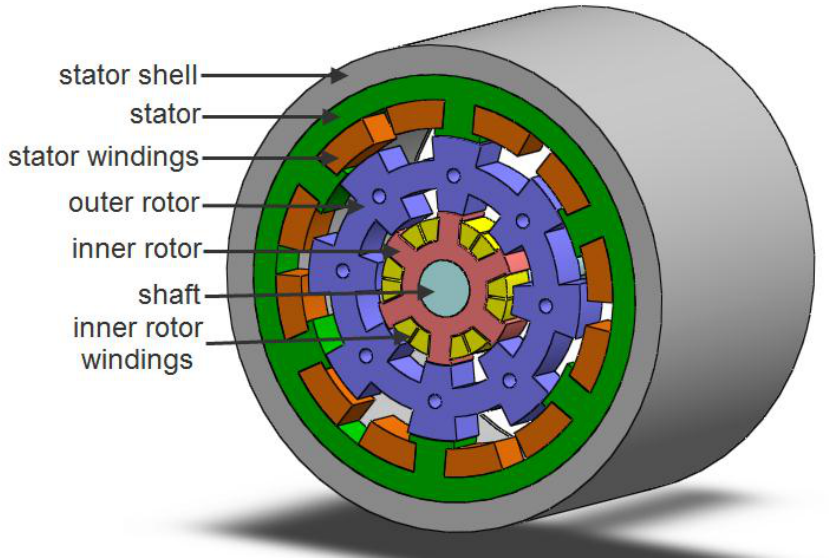
Figure 2. Structure of